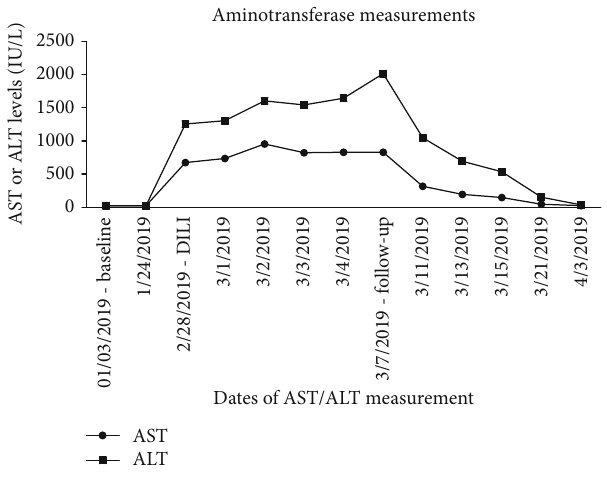
Figure 1: Aminotransferase measurements preceding, during, and following drug-induced liver injury. Measurements are expressed in international units per liter. AST peak was 950 on 03/02/2019; ALT peak was 2,007 on 03/07/2019. ALT: alanine aminotransferase; AST: aspartate aminotransferase; DILI: drug-induced liver